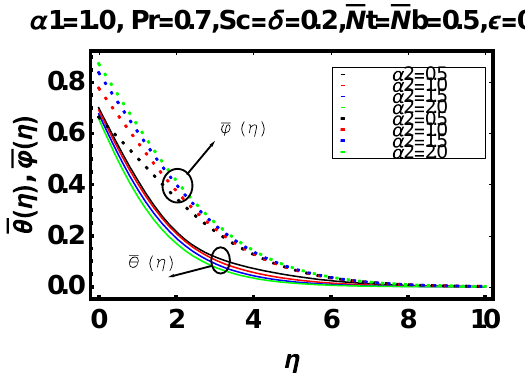
Figure 16. Temperature and concentration profiles for variant α 1 .